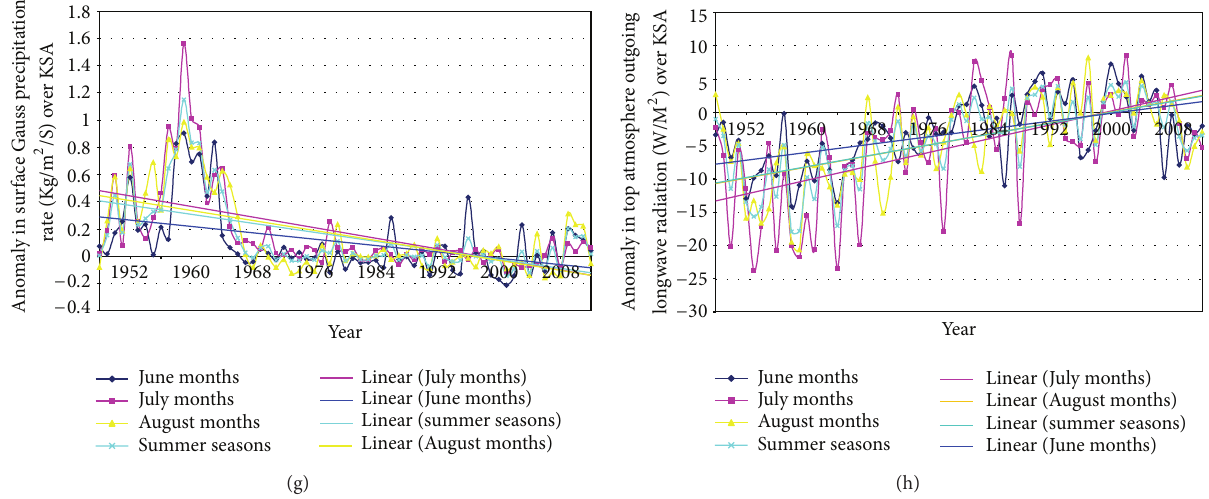
Figure 2: The time series and the linear trend for anomaly of weather meteorological elements over KSA through the period 1948–2012.